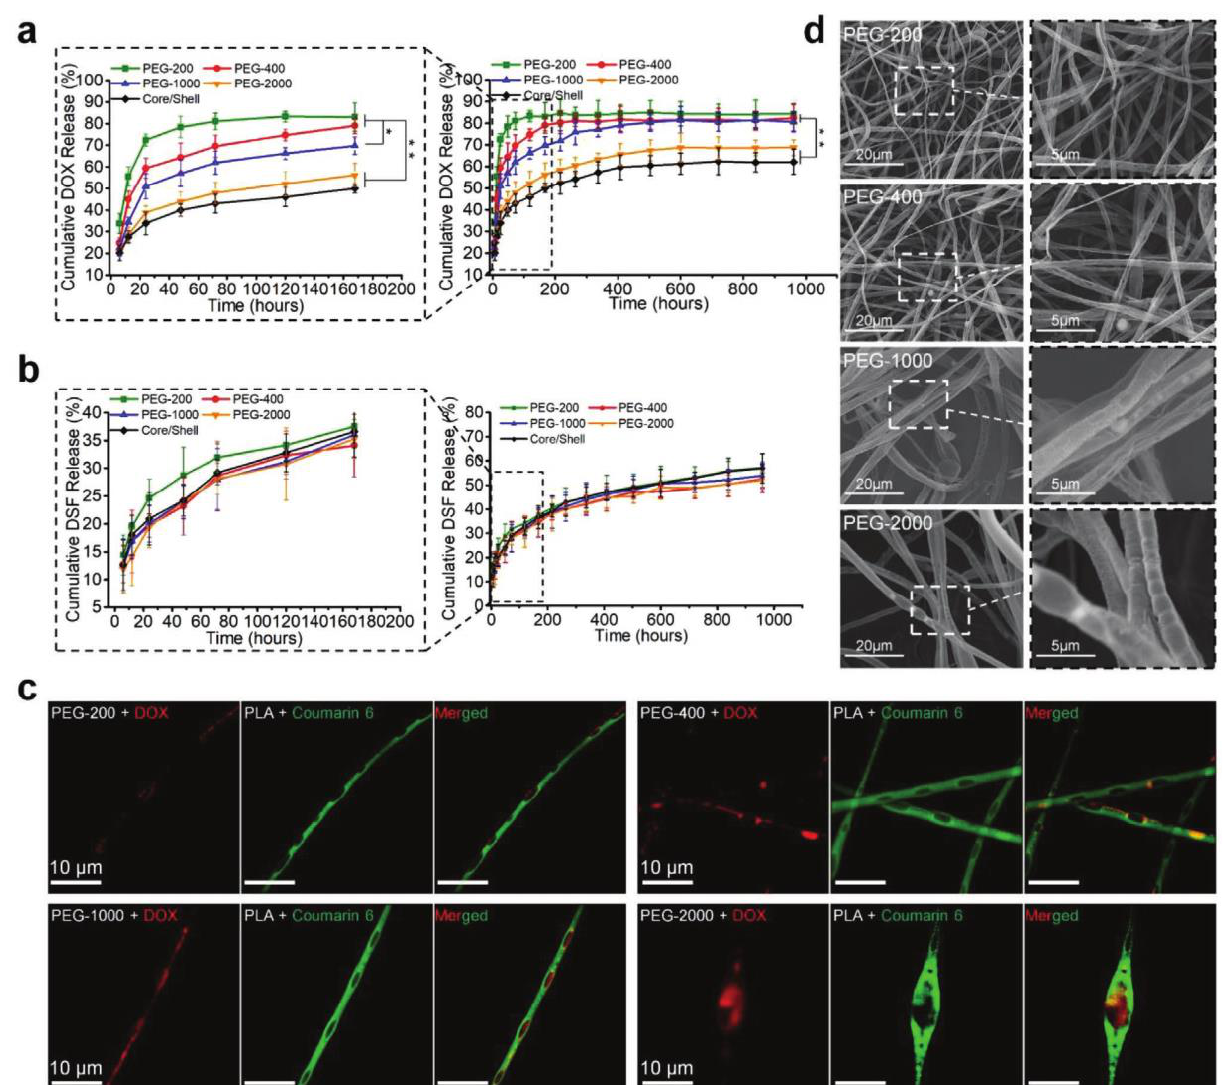
Figure 4. ( a ) Release behaviors of DOX-HCl. ( b ) Release behaviors of disulfiram (DSF) from different drug-loaded fiber devices in PBS (pH: 7.4, 37 °C). ( c ) In vivo antitumor recurrence and metastasis inhibition analysis. Orthotopic tumor images and pulmonary metastasis images of 4T1-Luc tumor- bearing mice at different times. Lung metastasis fluorescence images were taken ex vivo after the mice were sacrificed on day 42. ( d ) SEM images of the fiber devices (* P < 0.05 and ** P < 0.01). Reprinted with permission from ref. [62]. Copyright 2020 John Wiley and Sons.